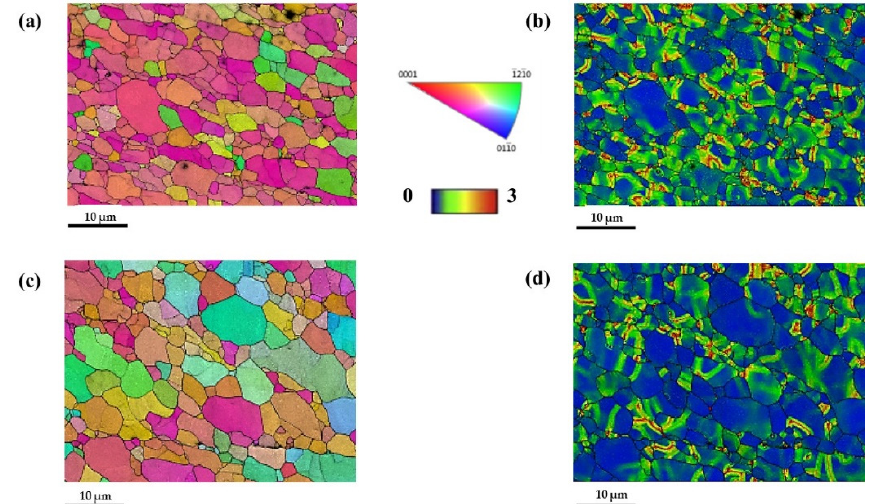
Figure 4. Microstructure of the SZ of fine-grained and ultra-fine-grained CP-Ti characterized by using EBSD; IPF and KAM map of fine-grained SZ are shown in ( a , b ), and those of ultra-fine-grained SZ are shown in ( c , d ), respectively (the scales of figures are equal in here).